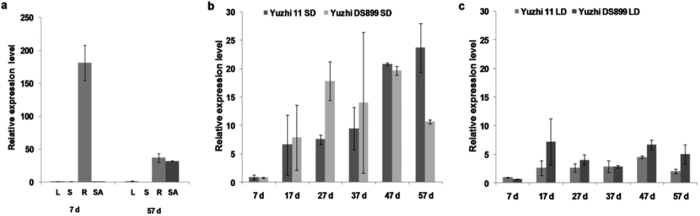
Expression of SiDt alleles in indeterminate and determinate lines of sesame.(a) Spatial profile of SiDt transcription in Yuzhi 11 at the vegetative (7 d) and flowering (57 d) stages under short days (SD) of 12 h light/12 h dark. L, S, R and SA on the x-axis indicate leaf, stem, root and shoot apex tissues, respectively. (b) Expression pattern of SiDt alleles in the shoot apex tissues of Yuzhi 11 and Yuzhi DS899 from 7–57 d under SD. Plants of 7–37 d were in the vegetative stage. (c) Expression pattern of SiDt alleles in the shoot apex tissues of Yuzhi 11 and Yuzhi DS899 from 7–57 d under long days (LD) of 15 h light/9 h dark. Plants of 7–57 d were all in the vegetative stage. The β-tubulin gene (SiTUB, JP631640) was used as an endogenous reference gene for qPCR. SiDt and Sidt1 transcript amount was normalized to β-tubulin and analyzed using the ΔΔCt method. Values were calculated from three independent biological replications. The error bar indicates the standard error of the mean.